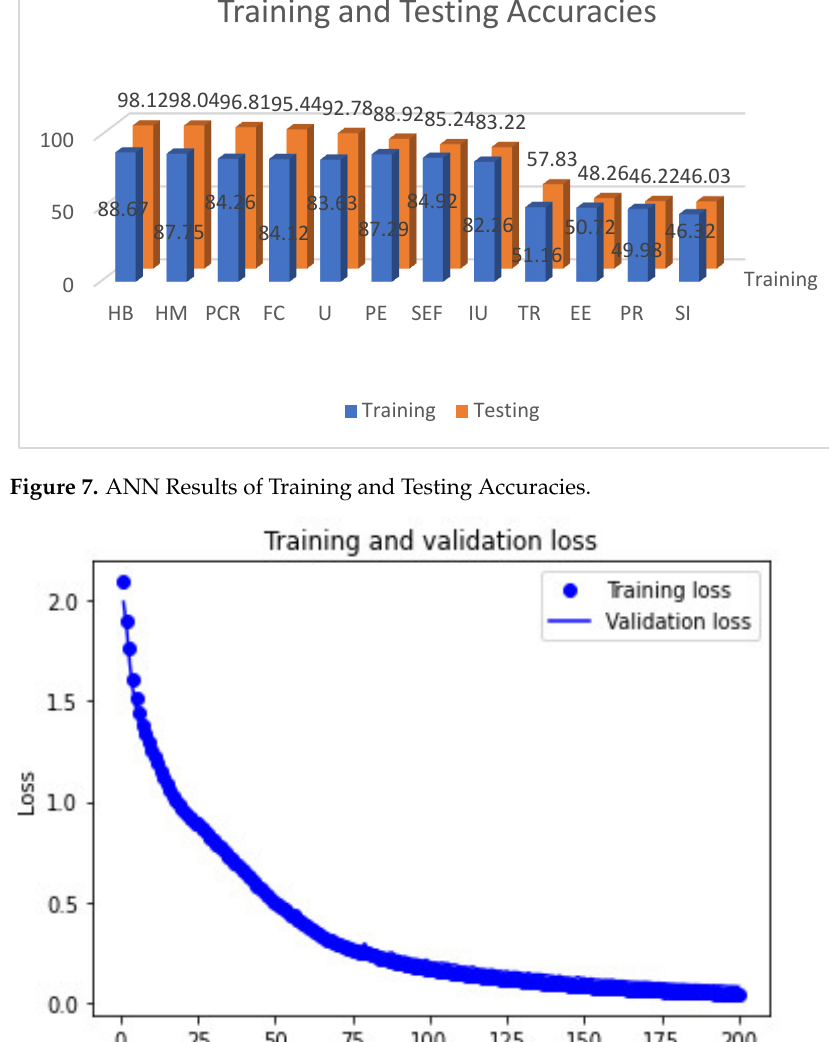
19 of 29 Figure 6. Optimum Random Forest Classifier.